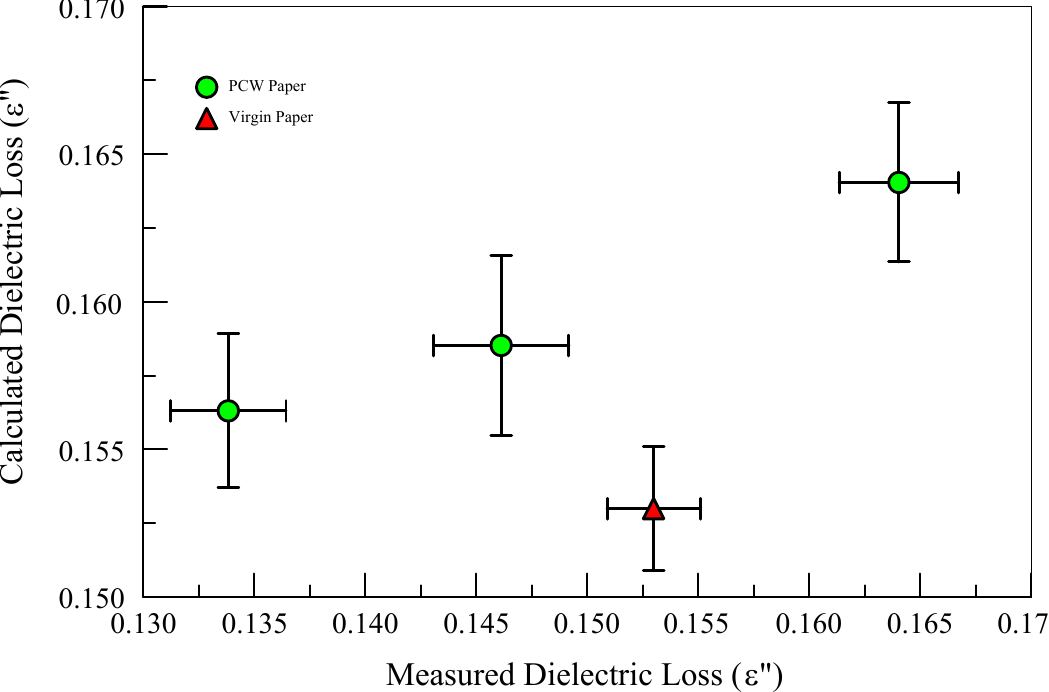
Figure 2. Comparison of the measured with the calculated expected dielectric loss of PCW recycled and virgin office copier papers produced by manufacturer B. The expected dielectric loss is based on a fraction ‐ weighted linear combination of the properties of 100% PCW recycled and virgin (0% PCW) papers. The vertical error bars assume the same systematic errors as in the measured dielectric loss. Recycling 2018 , 3 , x FOR PEER REVIEW The advertised brightness of the samples analyzed was 92 brightness for all the 50% PCW and